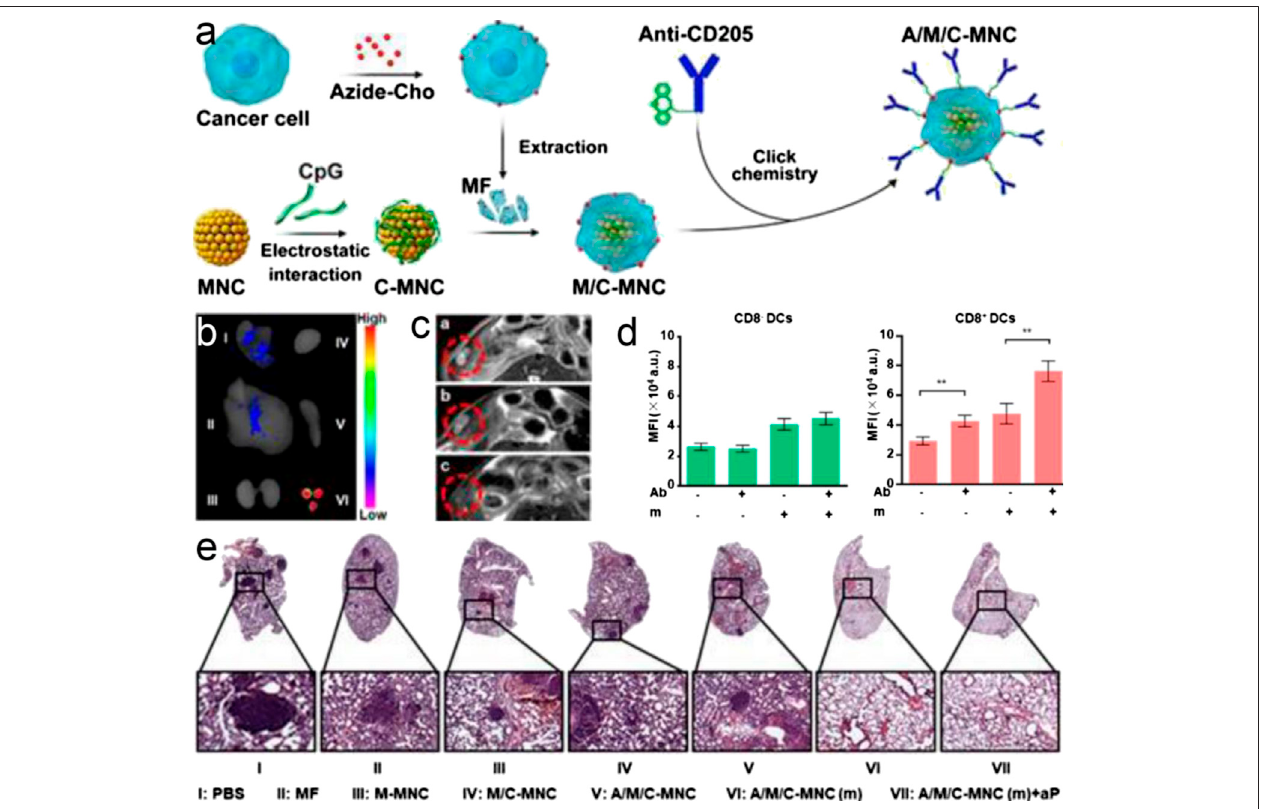
FIGURE 5 | (A) Fabrication process of A/M/C-MNC. (B) Fluorescence imaging of excised lymph nodes and visceral organs two days after vaccination with A/M/ C-MNC. I-VI were lung, liver, kidneys, heart, spleen, and lymph nodes, respectively. (C) In vivo T 2 -weighted MR imaging of mice vaccinated with different formulations. The red circles outline the lymph nodes. (D) MFI of DCs in the lymph nodes after vaccination with different DiD-labeled formulations. Ab, anti-CD205 conjugation; m, magnetic fi eld retention in the lymph nodes. (F) H&E-stained lung sections of different groups. All data represent the mean ± SD (n (cid:2) 6). Reproduced with permission from Liu S. et al. (2019). Copyright 2019 American Chemical